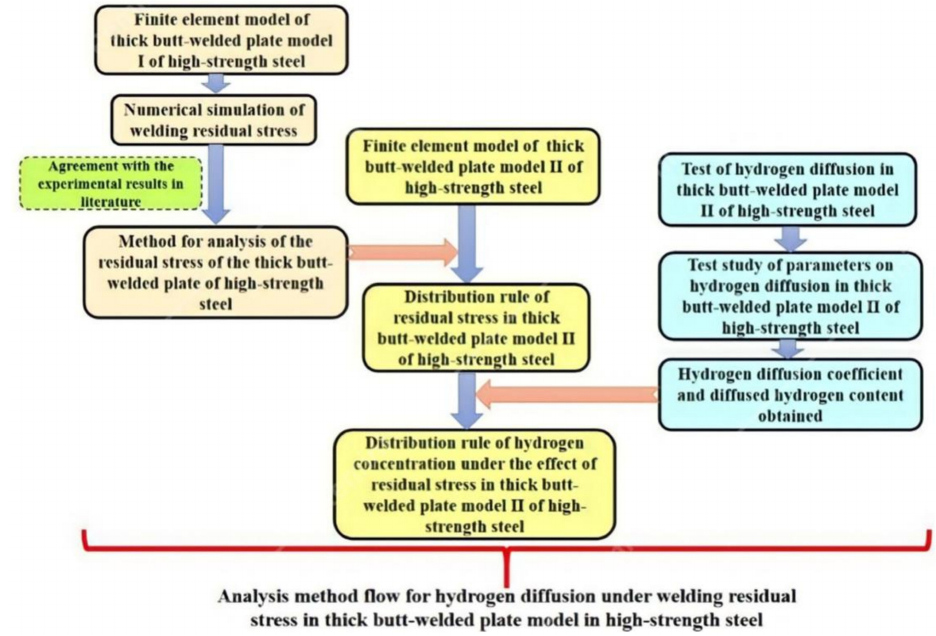
Figure 1. Method flow diagram for hydrogen diffusion